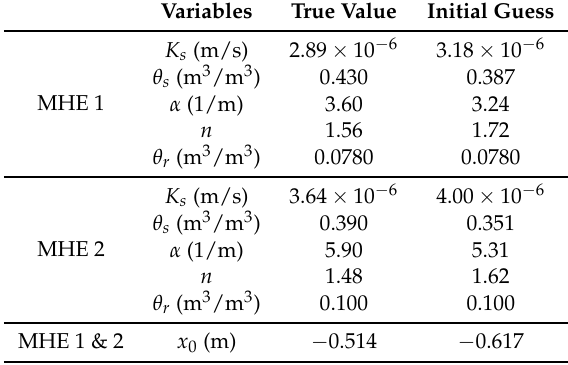
Table 4. True values of initial states and parameters of the process and the initial guesses used in